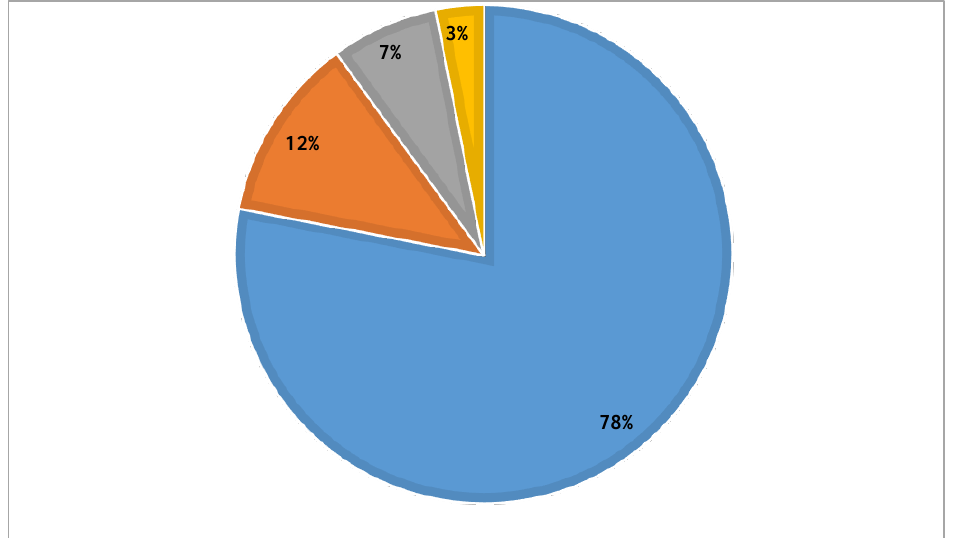
Figure 5. Reasons for engaging in value addition techniques X 2 =33.831; df=3 p<0.001